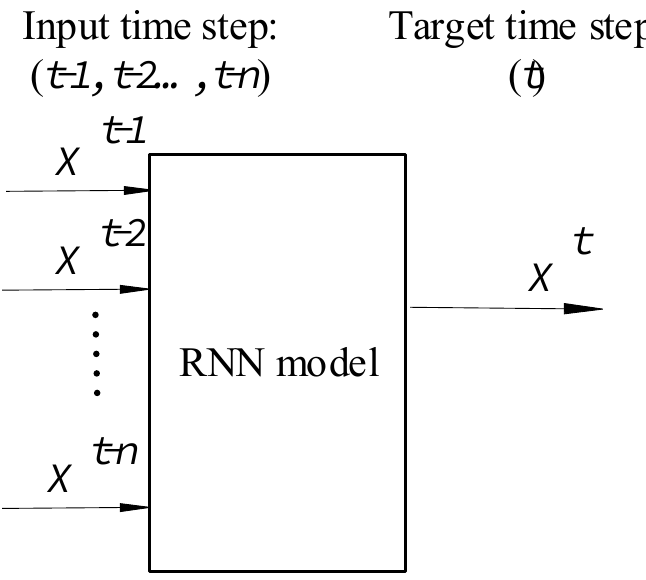
Figure 4 . Schematic SVR model for prediction of target variables T ma and T ahc at time t for fault symp ‐ tom detection.